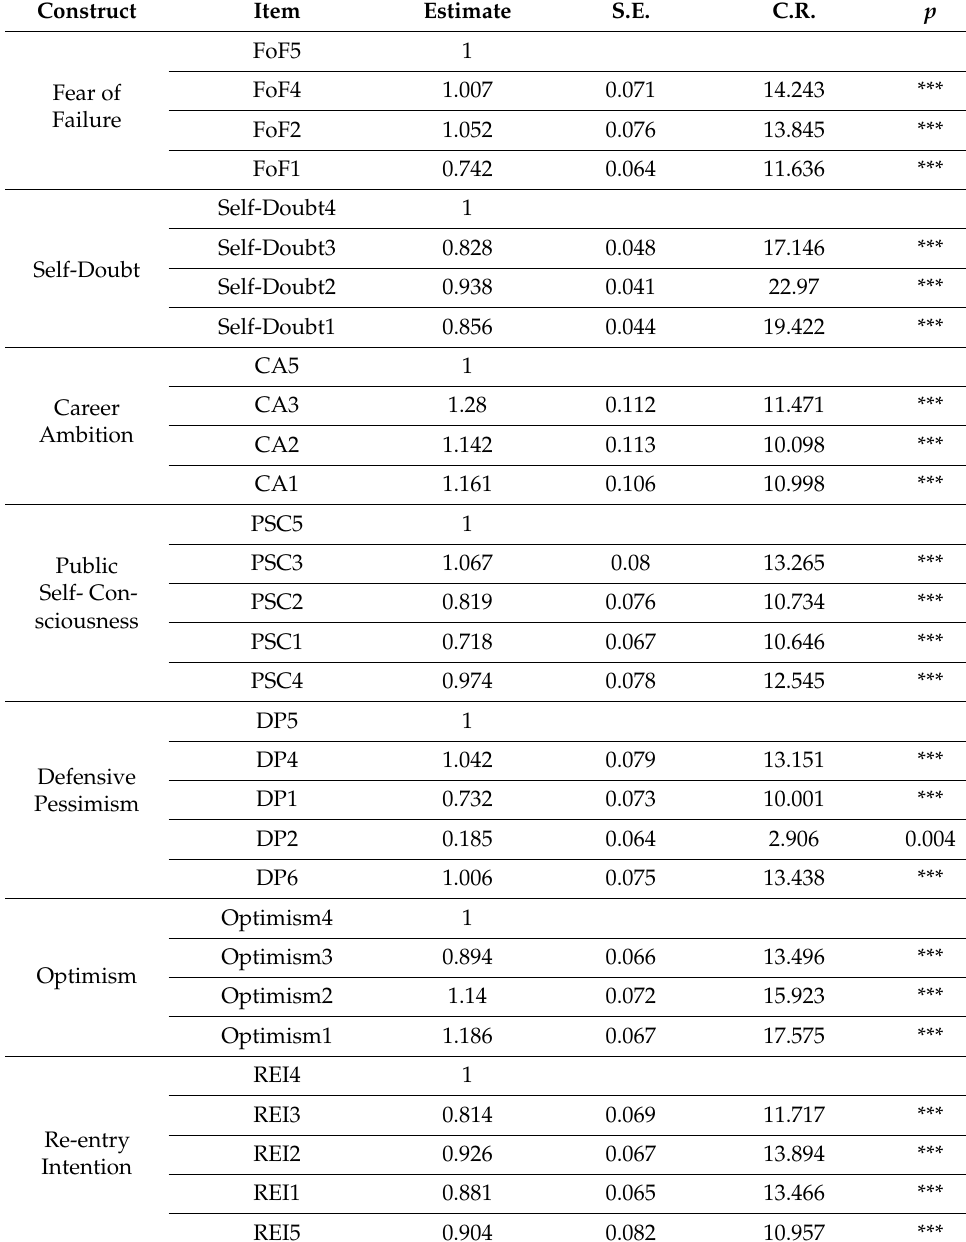
Table 2. Results of the confirmatory factor